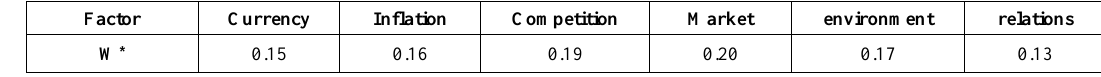
Table 3. The criteria final weights ( W *